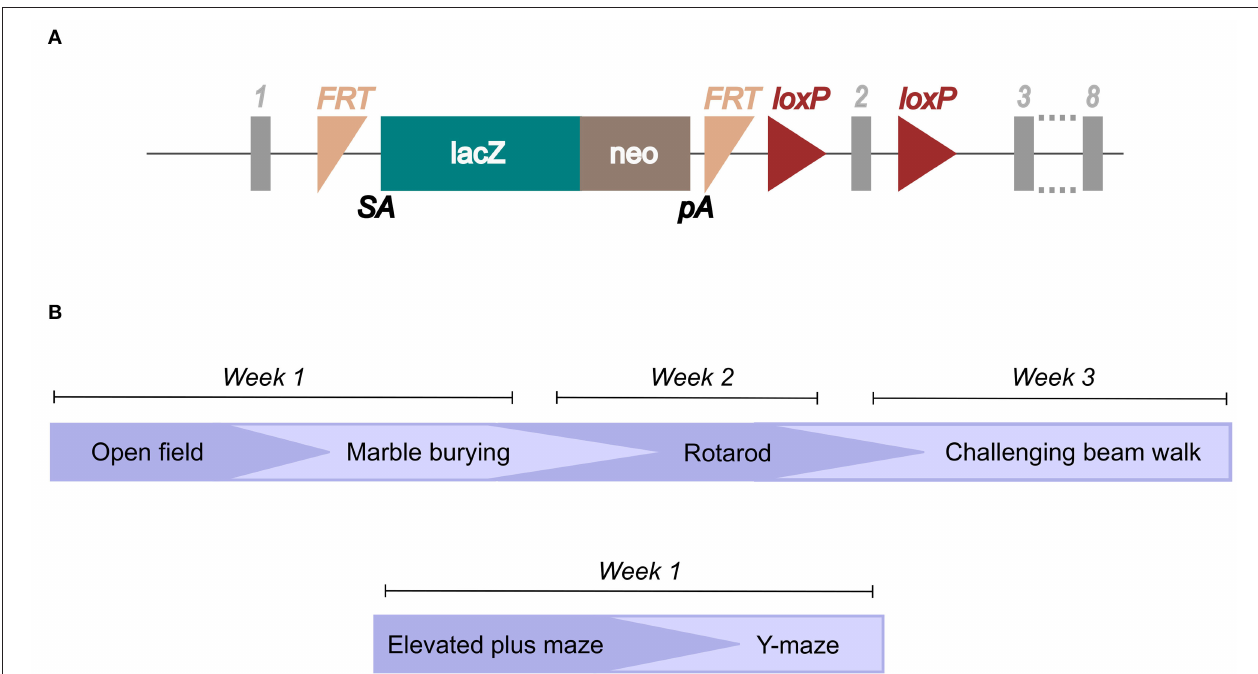
FIGURE 1 | Illustration of the knockout construct and study layout. The knockout mouse was imported from the International Mouse Phenotyping Consortium (IMPC; www.mousephenotype.org/data/genes/MGI:1919305), (A) and the knockout-first construct is illustrated (Created using data from Slc38a10, n.d.). Genotyping primers were designed toward the LacZ domain and the wild-type allele. (B) The study layout for which mice went through the different behavioral tests in the order illustrated.